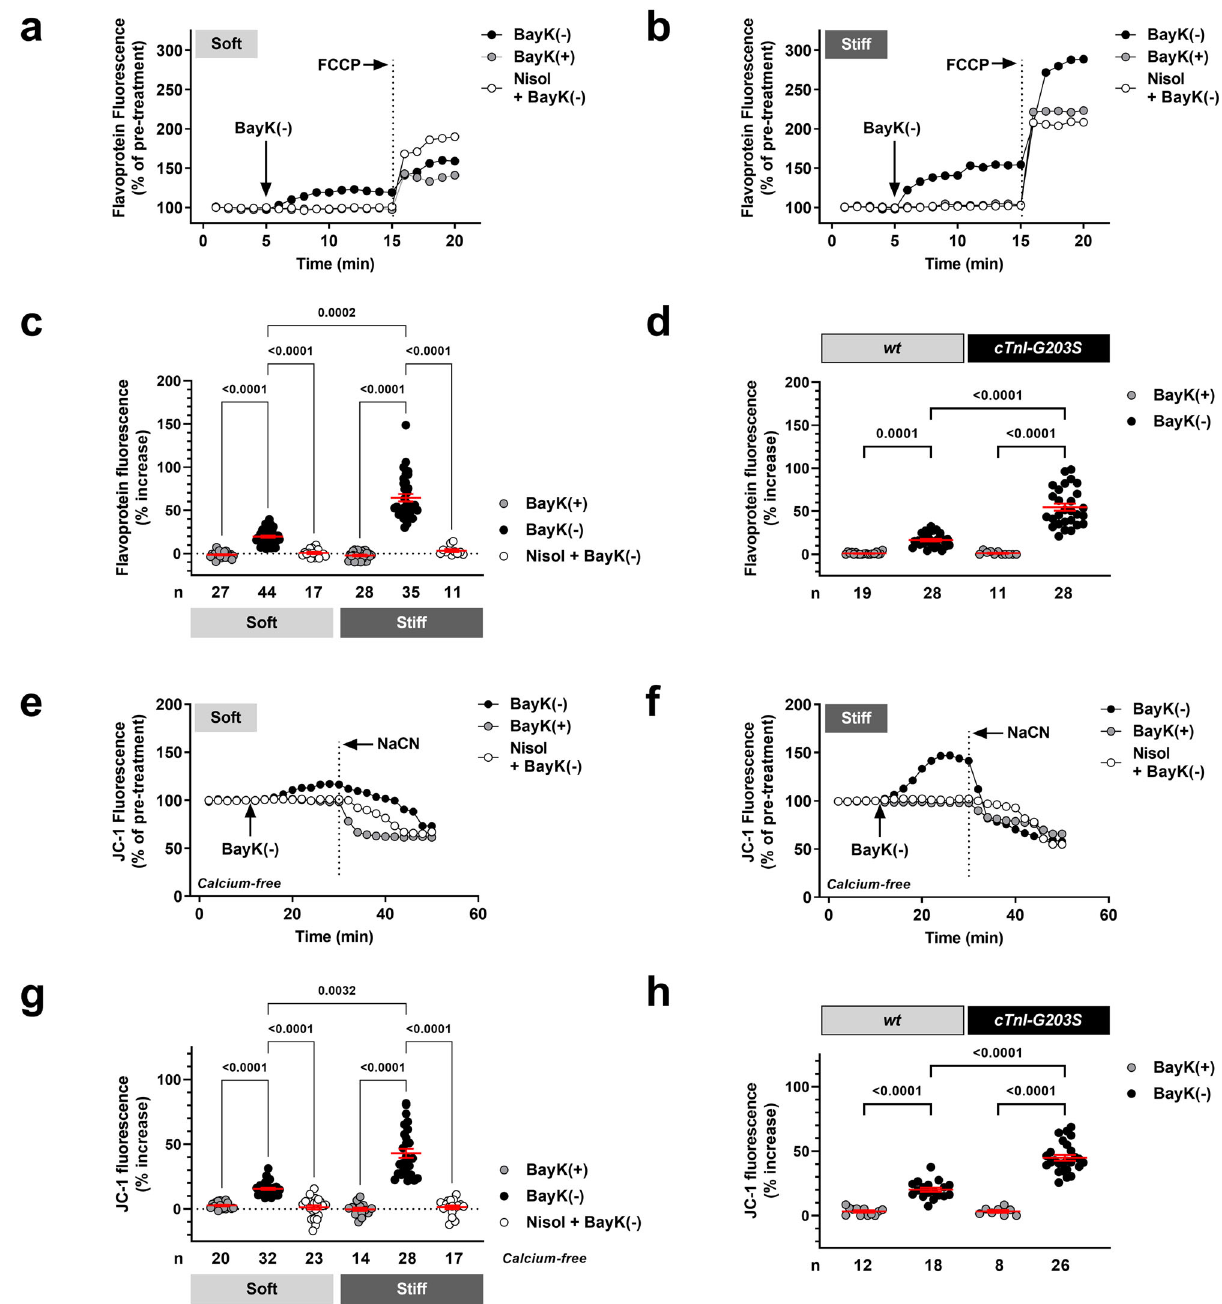
Fig. 2 Increased ECM stiffness contributes to the progression of HCM pathophysiology. Representative ratiometric fl avoprotein ( a , b ) and JC-1 ( e , f ) fl uorescence recorded from wt cardiac myocytes plated on soft and stiff hydrogels before and after exposure to 10 μ M BayK( + ), or 10 μ M BayK( − ) in the absence or presence of nisoldipine (15 μ M, Nisol). JC-1 studies were performed under calcium-free conditions (0 mM calcium). Arrows indicate addition of drugs. To con fi rm signals were mitochondrial in origin, FCCP (50 μ M) was applied at the end of each fl avoprotein experiment to increase fl avoprotein oxidation. NaCN (40 mM) was applied at the end of each JC-1 experiment to collapse Ψ m . Overall fl avoprotein ( c ) and JC-1 ( d ) fl uorescence for all myocytes ( n ) exposed to drugs as indicated, including mean ± SEM. d – h , fl avoprotein ( d ) and JC-1 ( h ) fl uorescence for cardiac myocytes ( n , in suspension) isolated from cardiomyopathic cTnI-G203S mice and wt counterparts after exposure to BayK( + ) or 10 μ M BayK( − ) 17 . All statistical signi fi cance determined by Kruskal-Wallis tests, or Browne-Forsythe and Welch ANOVA test ( i